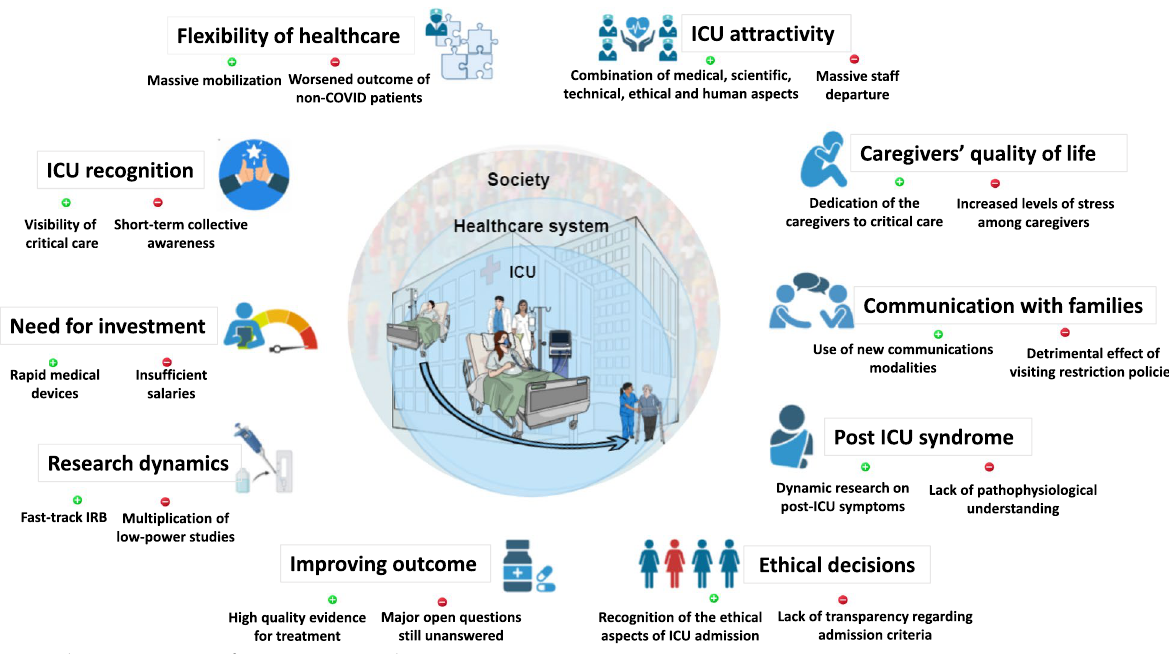
Fig. 1 The positive impact of COVID-19 on critical